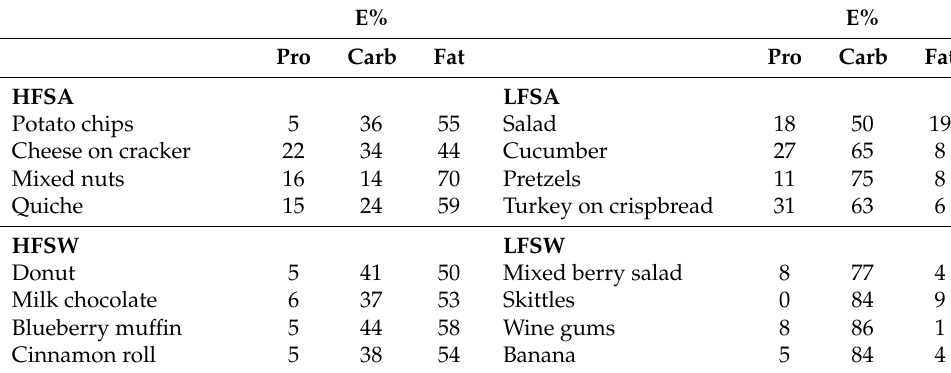
Table 2. Macronutrient content of the foods chosen for the LFPQ image